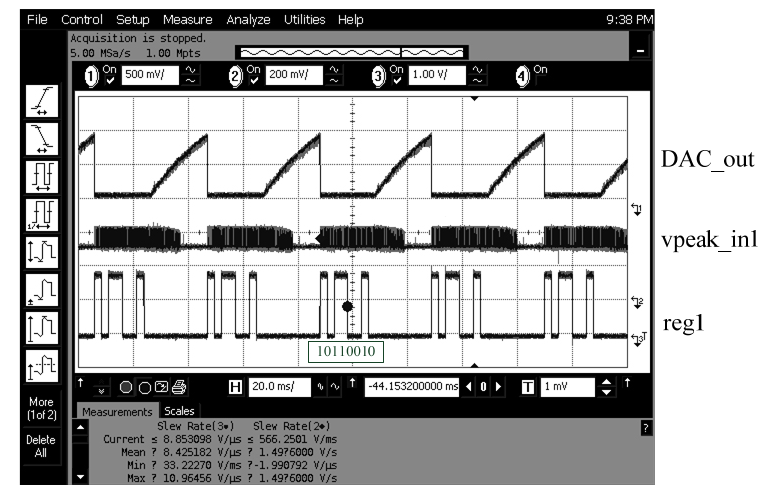
Figure 22. Measurements of the frequency-shift readout circuit.